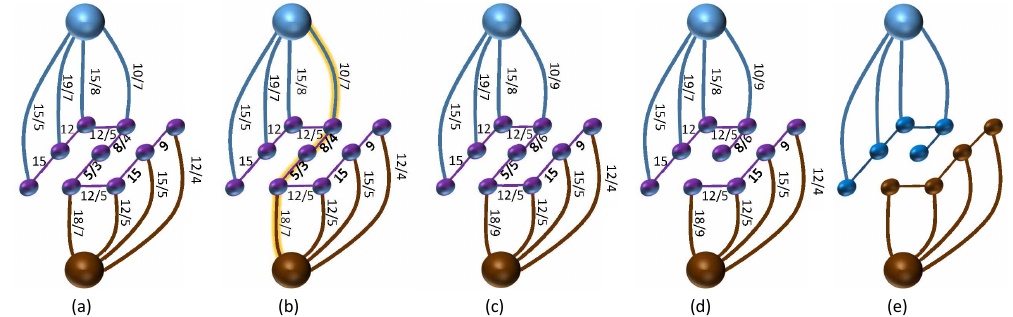
Figure 6. A simple scheme of an augmenting path procedure. ( a ) is a residual graph after a number of iterations. Here, the capacity and the current flow is presented for each edge (capacity/current flow), and all the saturated edges are removed; In ( b ), another path from source to sink is found; in ( c ), a flow equal to the maximum capacity is pushed through the path, and the residual graph is updated by eliminating the saturated edge; ( d ) is the final configuration of the residual graph, because there is no longer any connection between source and sink. So, based on the residual graph, in ( e ) the final label structure for the pixels is